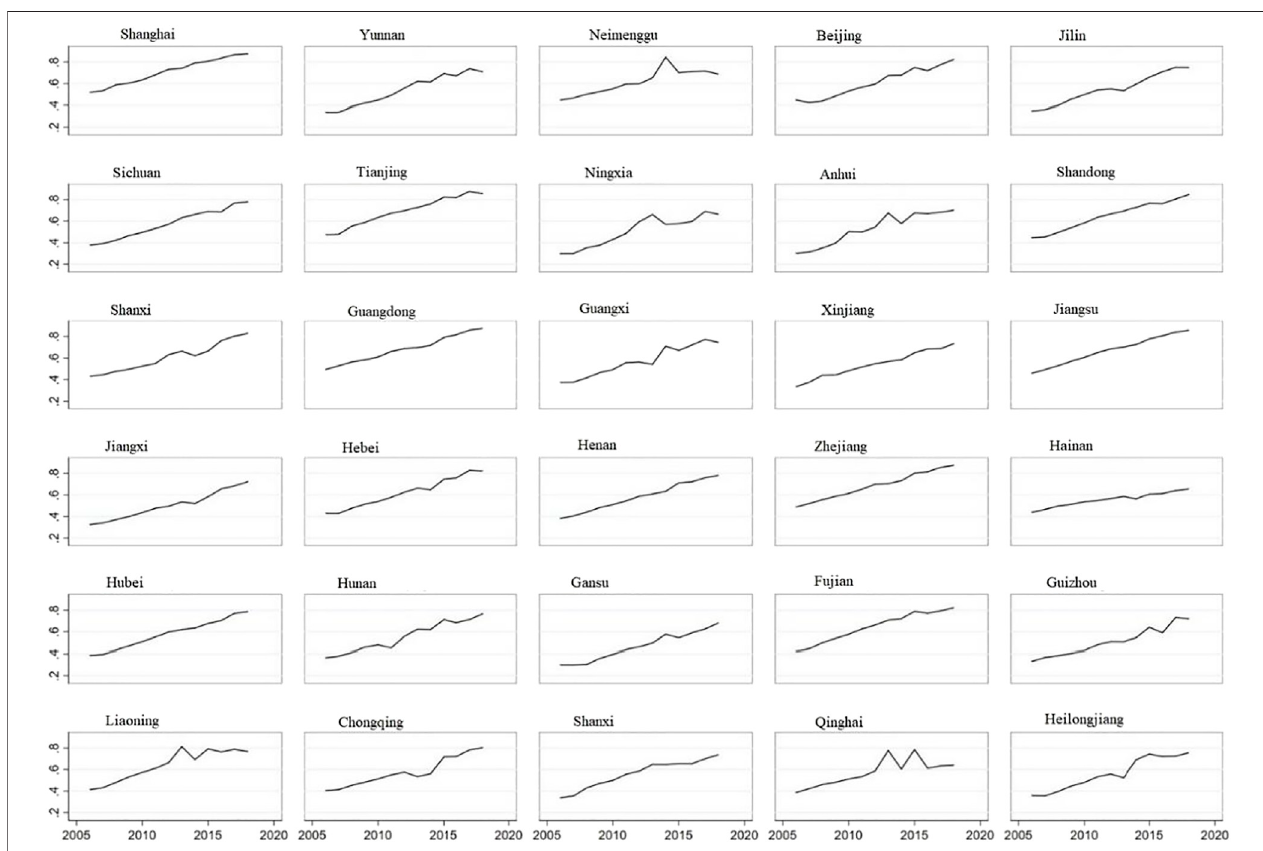
FIGURE 1 | Trend of industrial Internet development environment composite index of provinces and cities from 2006 to 2018. (Source: Drawing using Stata software).